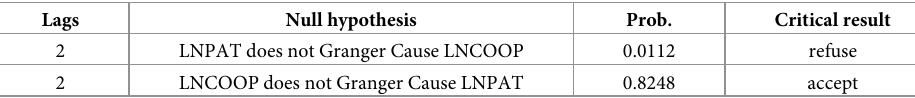
Table 10. Results of granger causality test between LNCOOP and LNPAT.